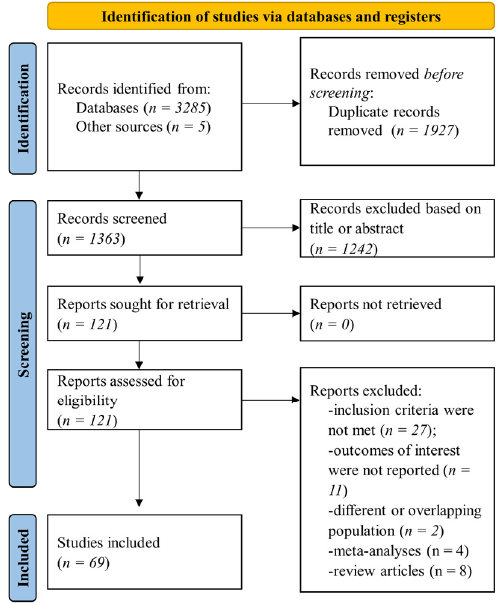
Figure 1. Flow diagram of selected studies in the present analysis.